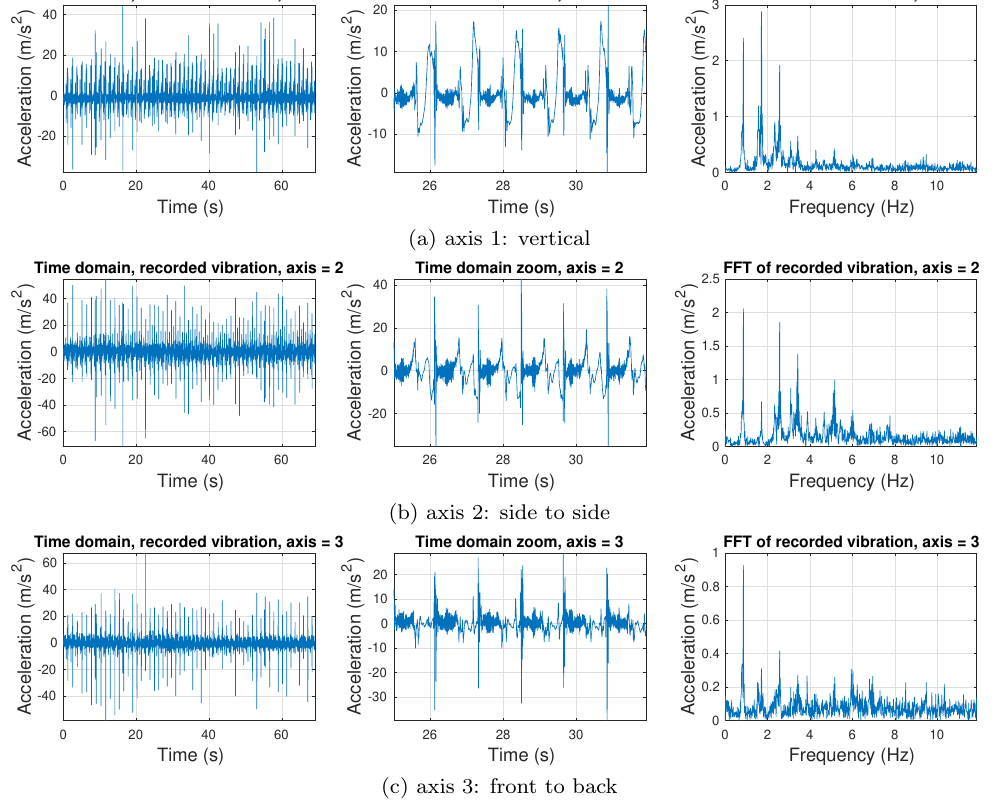
Figure 1: Walking at 3 km/h Figure 5. Analysis of gait acceleration in all three axes while walking at 3